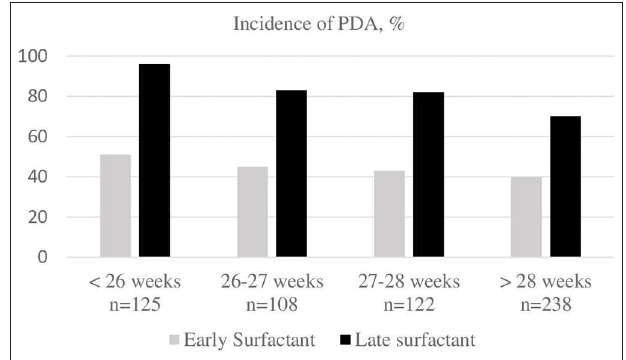
FIGURE 1 | Patent ductus arteriosus incidence among gestational ages compared by early vs. late surfactant timing. PDA, patent ductus